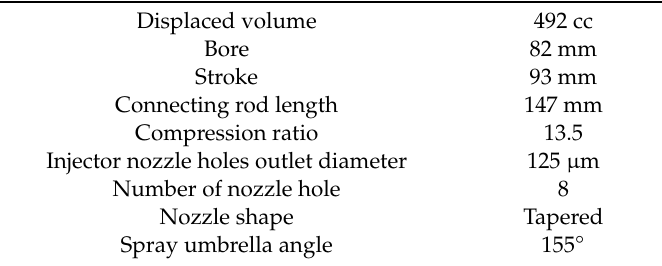
Table 1. Key dimensions of the engine and its